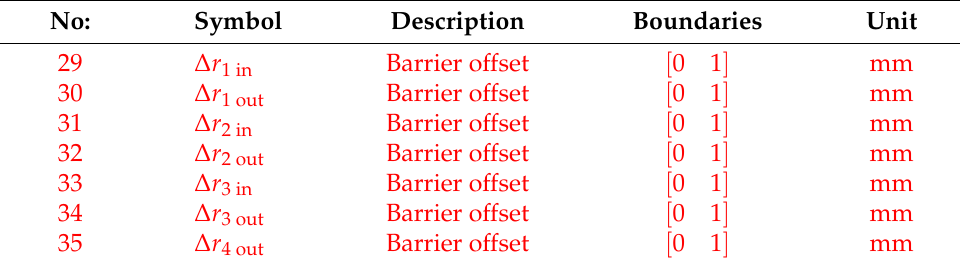
Table 3. Complete list of optimization